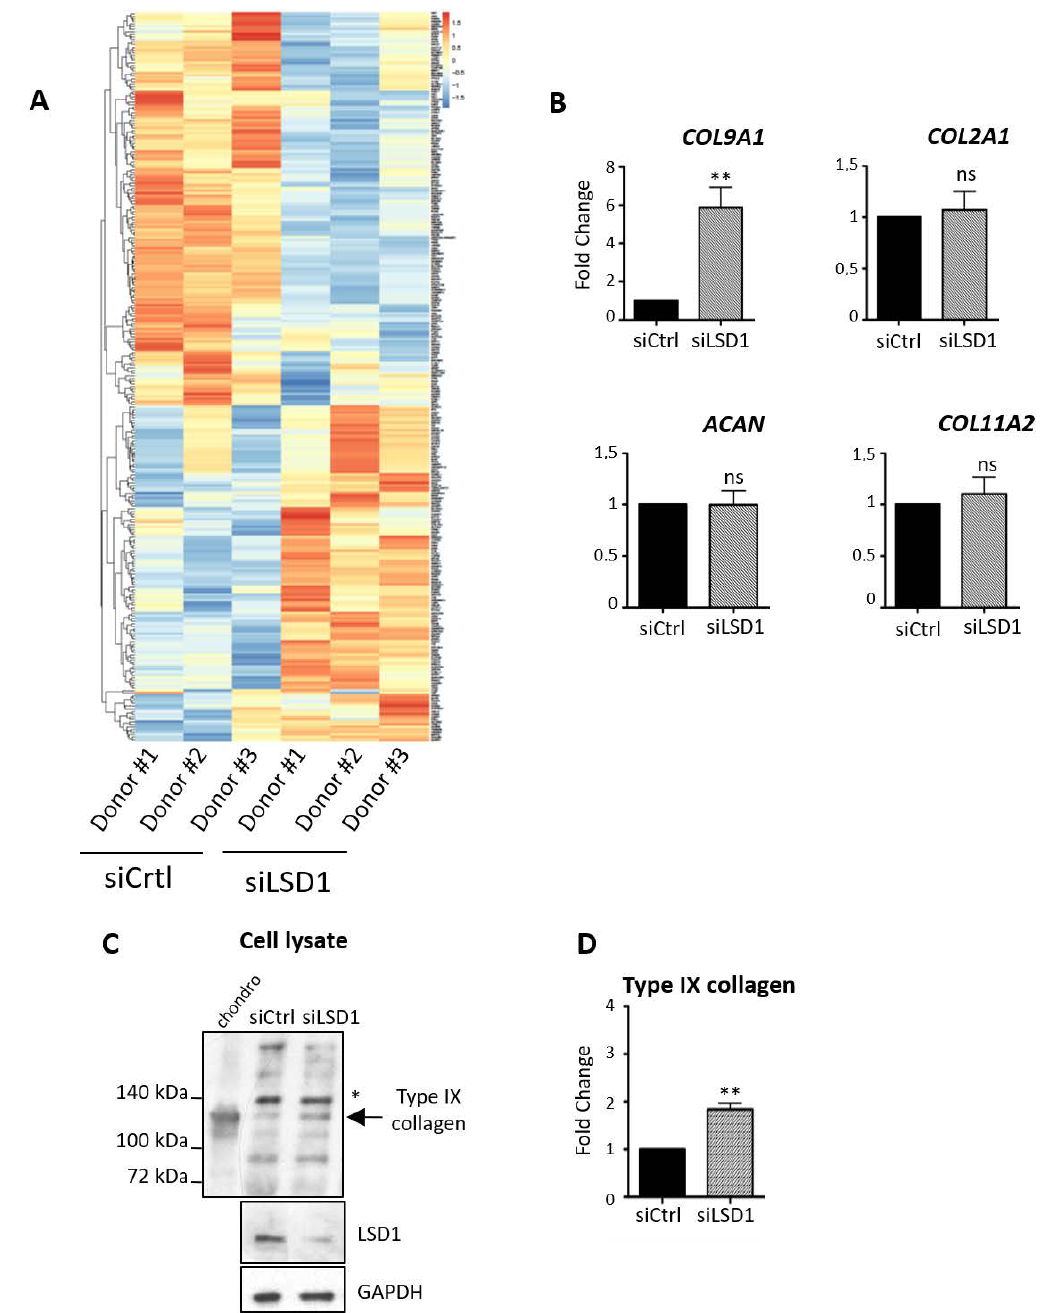
Figure 2. LSD1 down-regulates the expression of COL9A1 . ( A ) Heatmap of the top 280 regulated genes following LSD1 depletion in articular chondrocytes obtained from three di ff erent donors. ( B ) Real-time PCR of a set of collagen encoding genes from at least 3 other independent experiments. Results are presented as relative mRNA levels of COL9A1 , COL2A1 , COL11A2 and AGGRECAN ( ACAN ) normalized to RPLP0 (Student’s t -test * p < 0.05, ** p < 0.01). ( C ) Protein expression of type IX collagen was analyzed by Western blot in cell lysates from human chondrocytes cultured after LSD1 knock-down. Mouse costal chondrocytes (chondro) were used as a positive control ( n = 3). ( D ) Corresponding quantification was performed using ImageJ software (Student’s t -test ** p < 0.01).